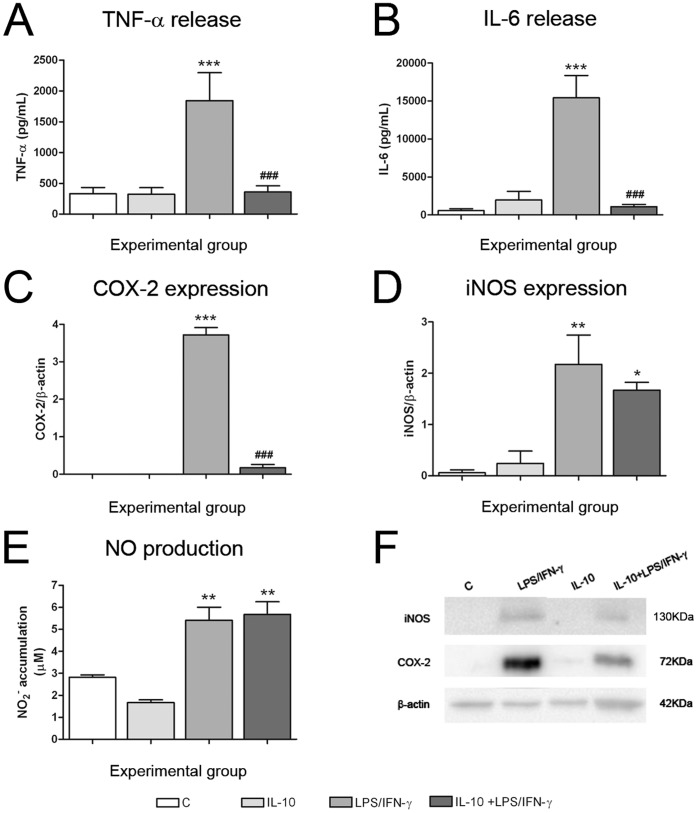
IL-10 pre-treatment inhibited the pro-inflammatory response induced by LPS/IFN-γ in primary microglia cultures.Primary microglial cultures were treated with 100 ng/mL LPS +30 ng/mL IFN-γ for 24 h in the presence or absence of 50 ng/mL IL-10 administered 1 h prior to LPS/IFN-γ. TNF-α (A) and IL-6 (B) levels were determined in the culture medium 24 h after treatment. (C) COX-2 and (D) iNOS protein expression were measured by western blot 24 h after treatment, and data normalized by β-actin. (E) NO production was determined in the culture medium 24 h after treatment. Bars are means + SEM of three to four independent experiments. *p<0.05, **p<0.01 and ***p<0.001 vs control; ###p<0.001 vs LPS/IFN-γ; one-way ANOVA (repeated measures) and Newman-Keuls post-test. (F) shows a representative western blot.